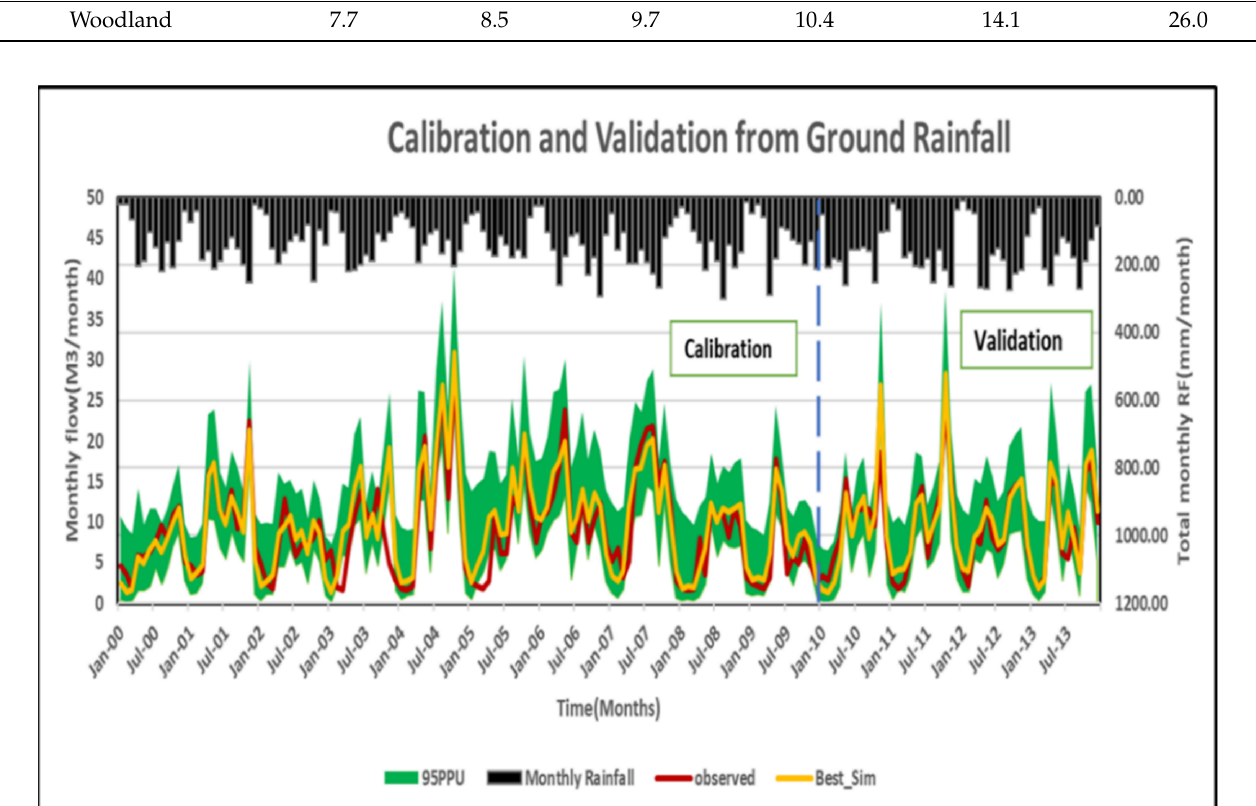
Figure 7. Observed and simulated monthly streamflow hydrographs for the calibration period of 2000–2010 and the validation period of 2011–2013 (separated by the vertical dashed line) for 2008 land Cover. Notes: Calibration; R 2 = 0.79, NSE= 0.79 & PBIAS= − 12; Validation: R 2 = 0.78, NSE = 0.69, and PBIAS = − 14.0.